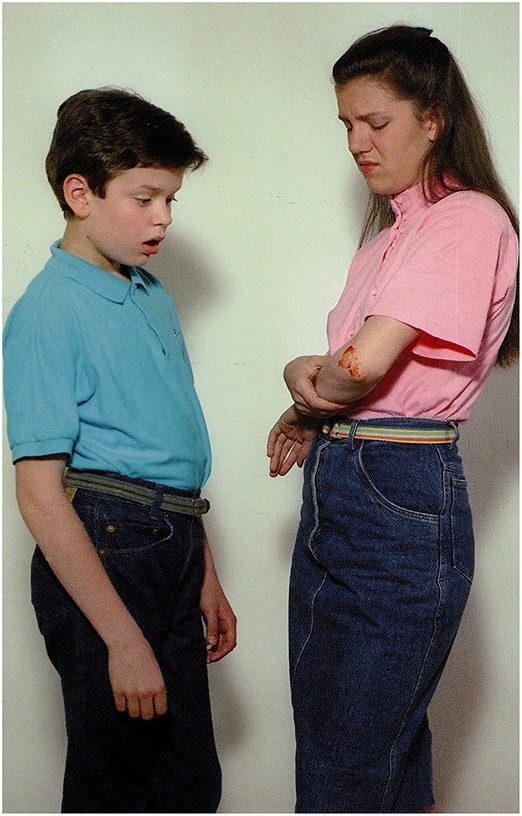
A girls is showing her scar to a boy (Stark, 1998).